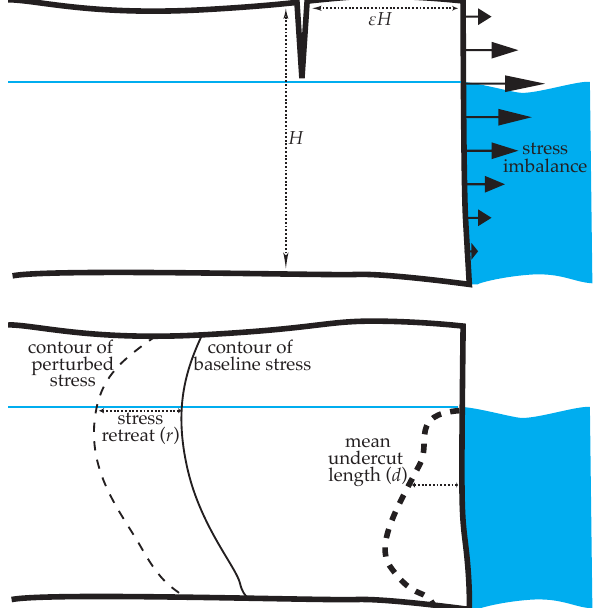
Fig. 1. Above: schematic of the geometry used in this study. Below: schematic of change in stress due to an undercut. The stress retreat r is the distance between a stress contour in the baseline state, and the equivalent contour in the perturbed state, measured along the